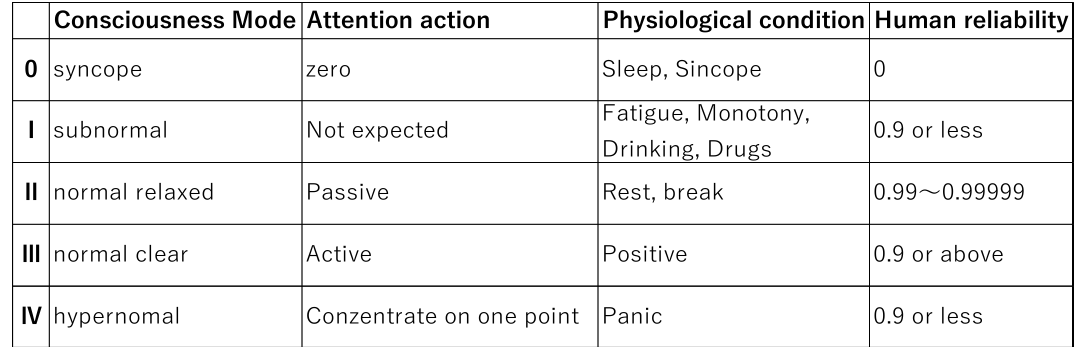
Table 1. Phase theory (awakening level) (Hashimoto,